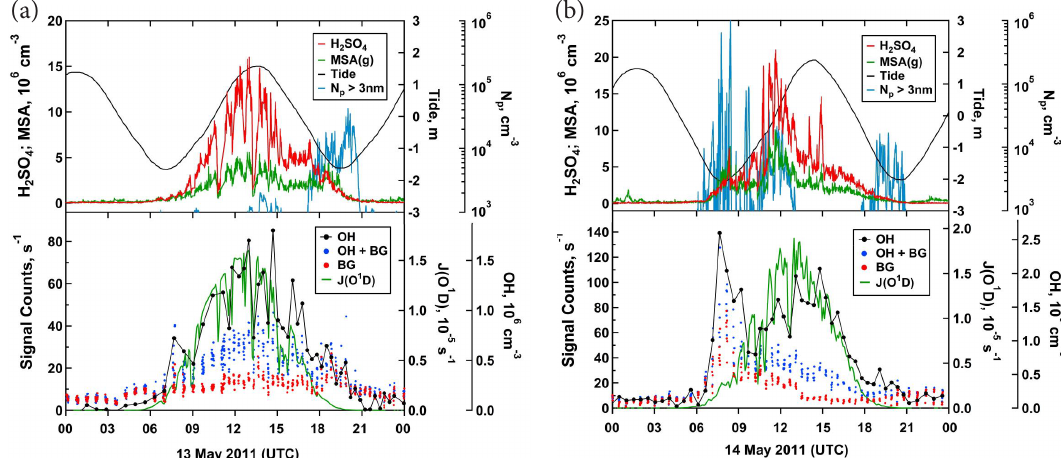
Figure 8. (a) Example observation showing relationships between aerosol nucleation events at low tide, OH concentrations, and OH back- ground (BG) signal (due to X compound). Top: H 2 SO 4 and MSA(g) concentrations (30s integration), tidal height, and total particle number concentration N p >3nm diameter (30s integration) measured with a condensation particle counter (CPC; TSI 3025). Bottom: OH con- centrations (5min; black dots), count rates for OH + BG and BG only (non-OH) signals (30s), and ozone photolysis frequency ( J (O 1 D)). (b) Example of increased OH concentrations and OH background signal (BG) during two aerosol nucleation events at low tide under marine sector conditions. Symbols as in (a)